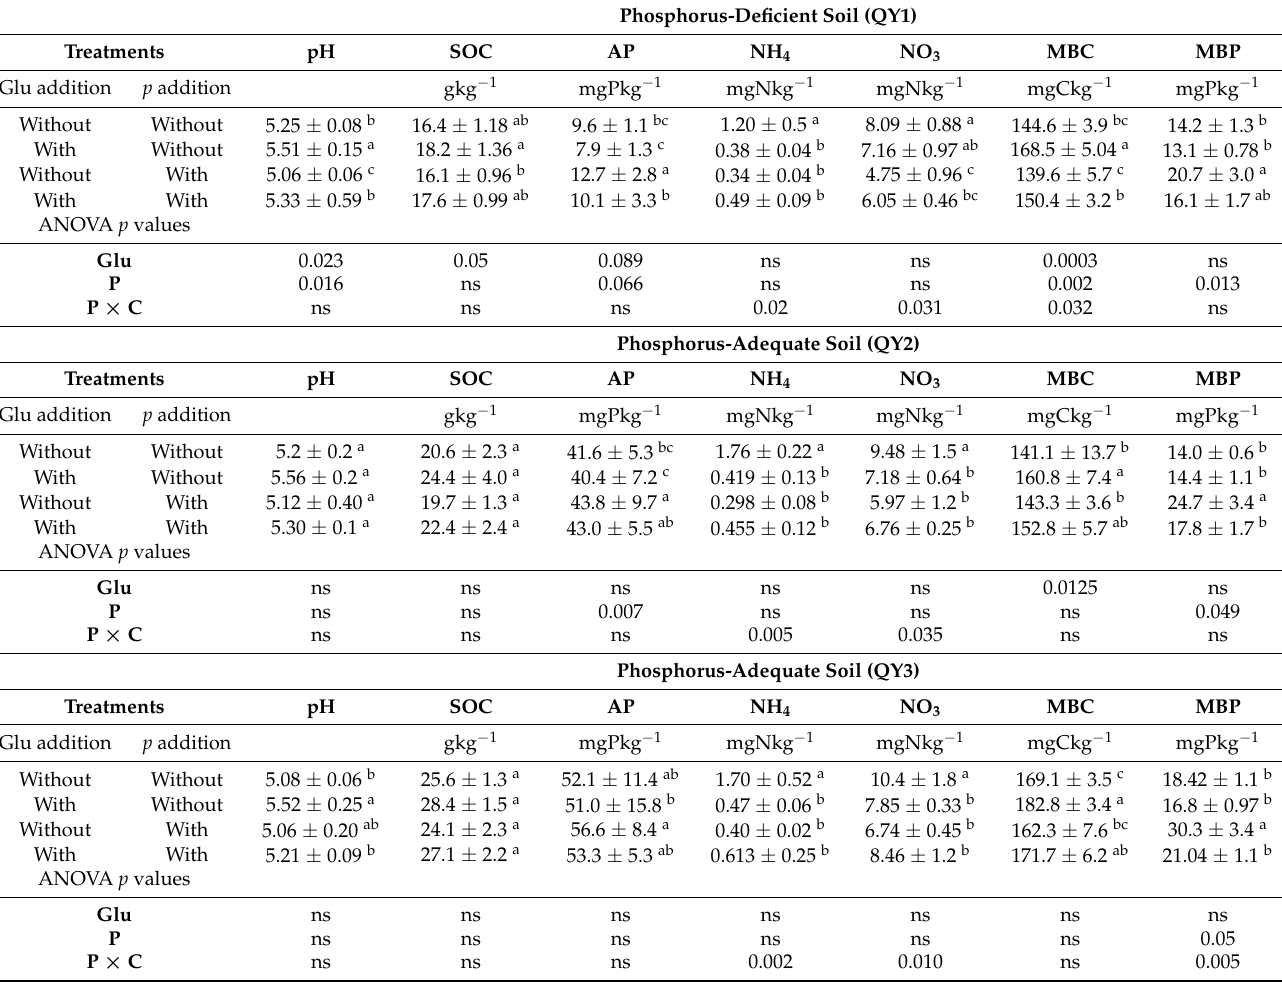
Table 2. Mean ± standard error (SE, n = 3) of soil pH, soil organic carbon (SOC), soil available phosphorous (AP), exchangeable ammonium (NH 4+ ), nitrate (NO 3 − ), microbial biomass carbon (MBC) and microbial biomass phosphorous (MBP) in phosphorous-deficient (QY1) and -adequate soils’ (QY2 and QY3) responses to glucose and phosphorus addition during incubation period. Different letters indicate significant differences. ns means non-significant.